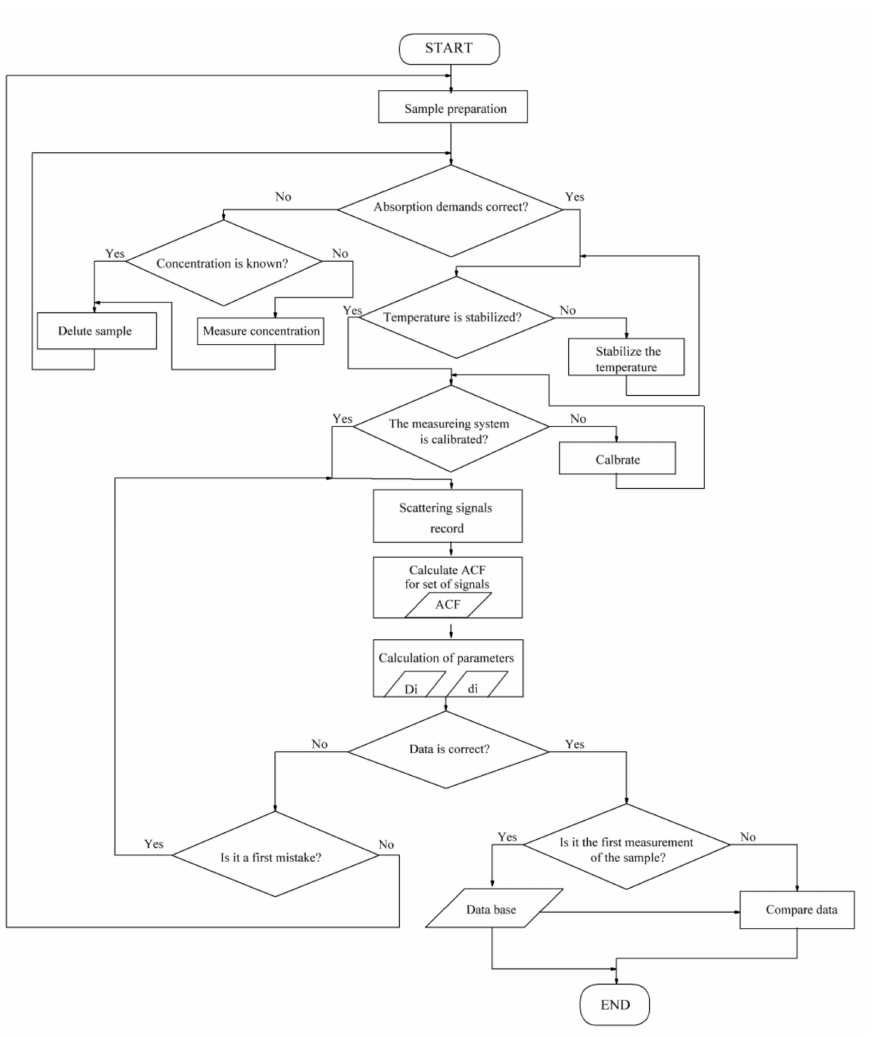
Figure 2. Algorithm for conducting the LCS